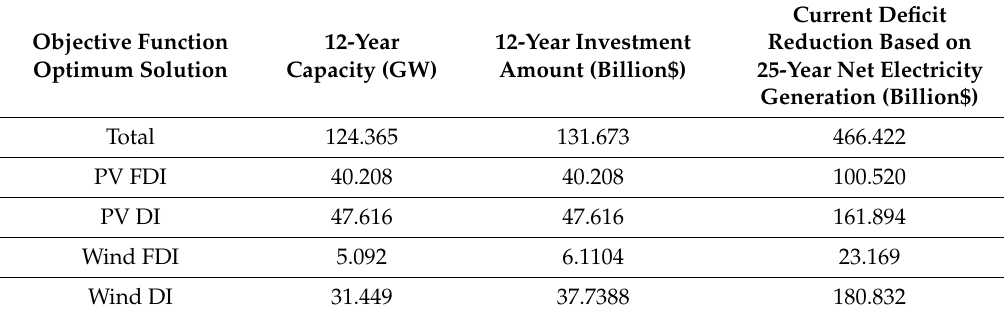
Table 2. Model Analysis